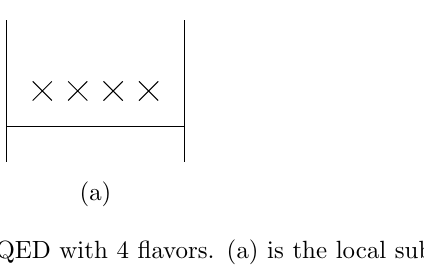
Figure 6. Model with moduli space: M H = (cid:22) O the maximal nilpotent orbit of sl (4). (a) Quiver. (b) Coulomb branch. (c) Higgs branch.